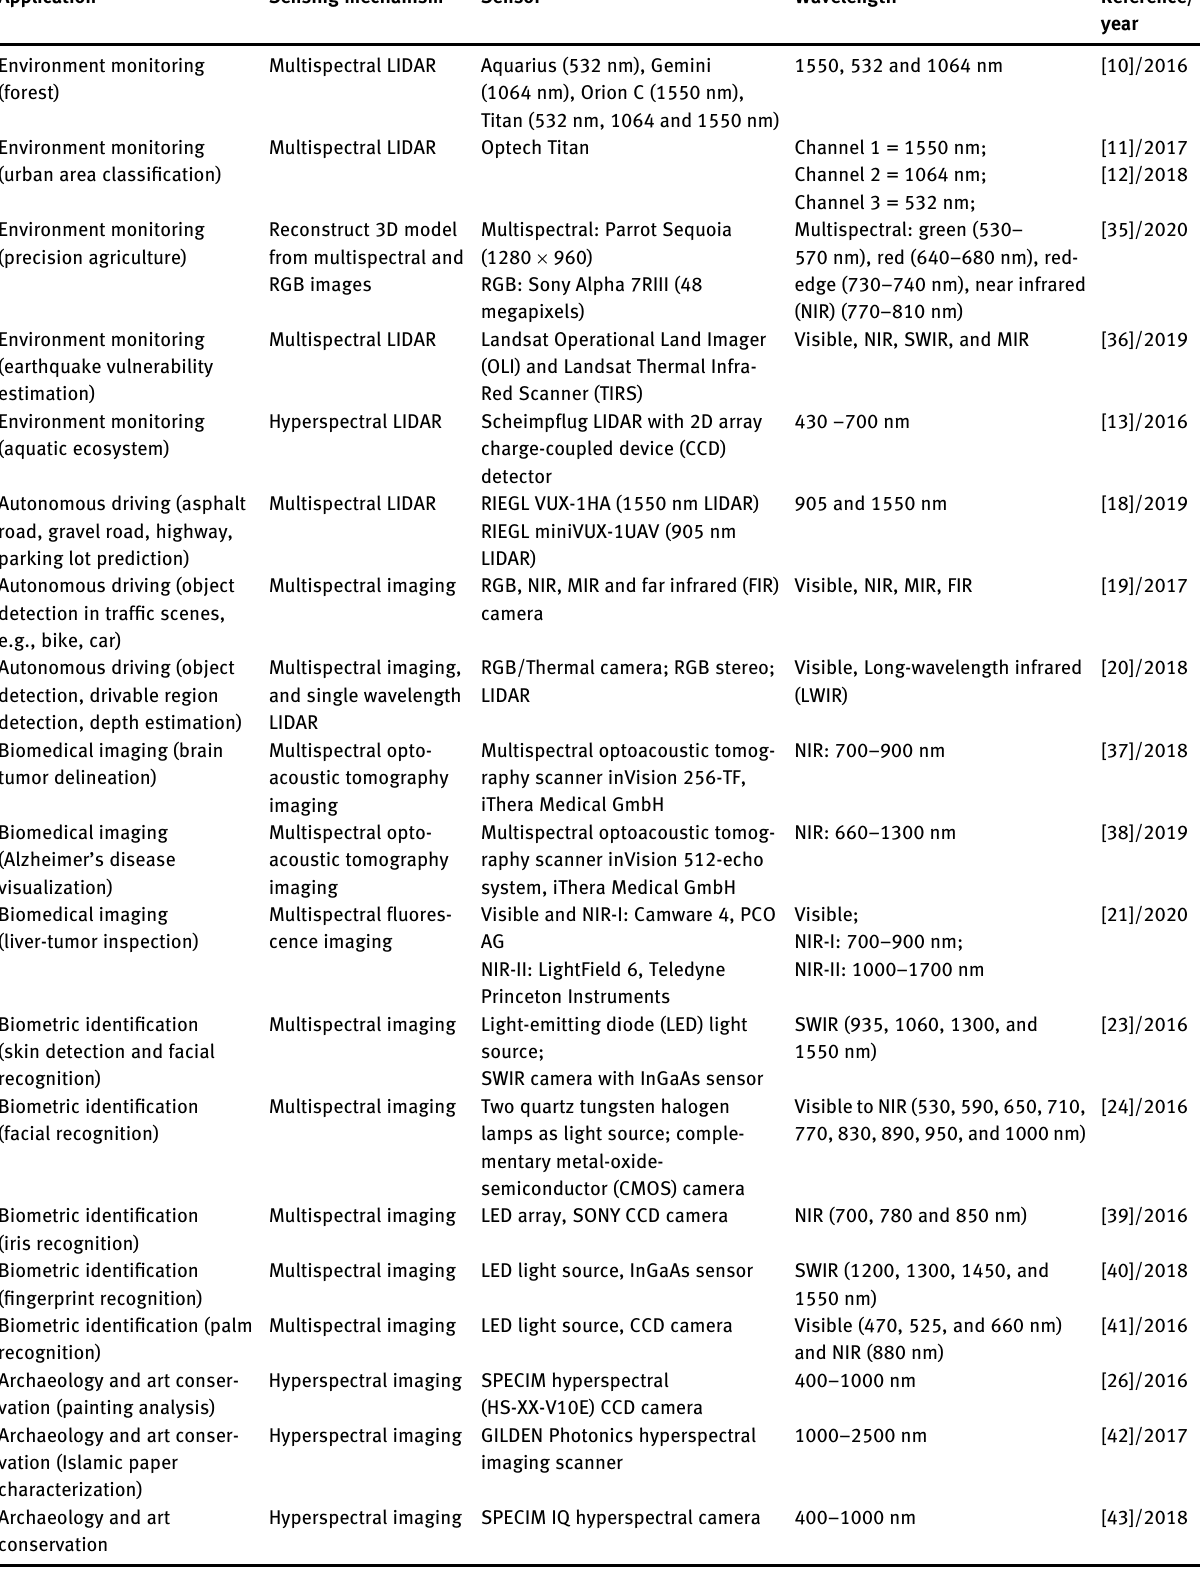
Table  : Summary of the current state-of-the-art spectral imaging and spectral LIDAR sensing systems for modern